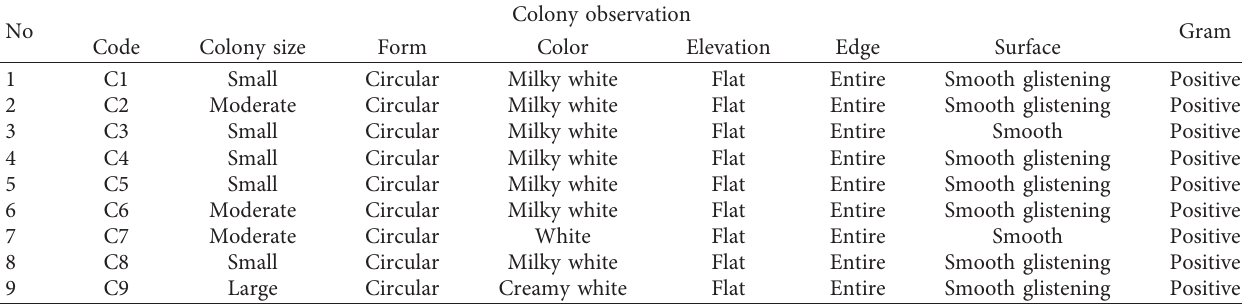
Table 1: Morphological characterization of purified isolates.